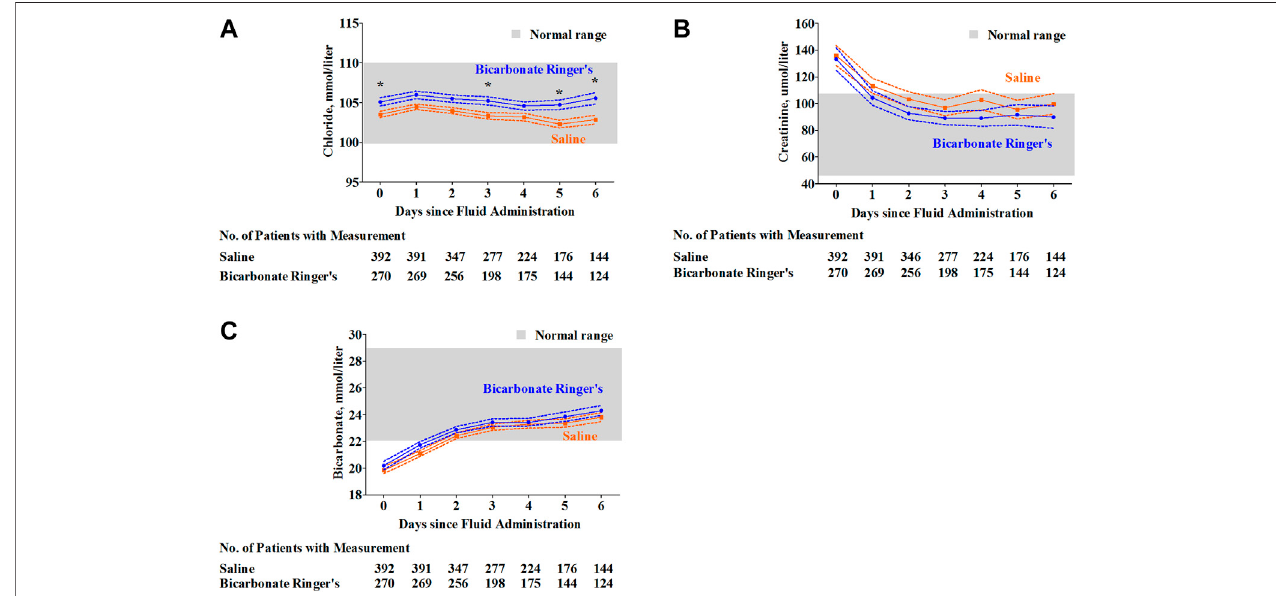
FIGURE 4 | Plasma chloride, creatinine and bicarbonate concentration of each group over seven days after the fl uid administration. Over 6 days after the administration of either fl uid for each group, the mean and standard error for the measurement of blood biochemical indexes including chloride (A) , creatinine (B) and bicarbonate (C) .Although themeanvalue ofplasmachloride levels waswithinthenormalrange, asigni fi cantdifference inplasma chloride levels wasobservedbetween the saline group and bicarbonate Ringer ’ s group [F fl uid type (3, 3373) = 48.00; p < 0.0001], post hoc Bonferroni test revealed signi fi cant difference on 0th day ( p < 0.05), 3rd day ( p < 0.05), 5th day ( p < 0.05) and 6th day ( p < 0.05), respectively (A) . Plasma creatinine levels were signi fi cantly decreased from an abnormal range to a normal range for both groups [F time (6, 3372) = 8.46; p < 0.0001] from 0th day to 6th day. A signi fi cant difference in plasma creatinine levels was observed between the salinegroupandbicarbonateRinger ’ sgroup[F fl uidtype (1,3372)=4.44; p =0.0352],buttheposthocBonferronitestrevealednosigni fi cantdifferencesbetweengroups at any time point (B) . Plasma bicarbonate levels were increased from relative acidic level (lower than 22.0 mmol/L) to the normal range from 0th day to 6th day [F time